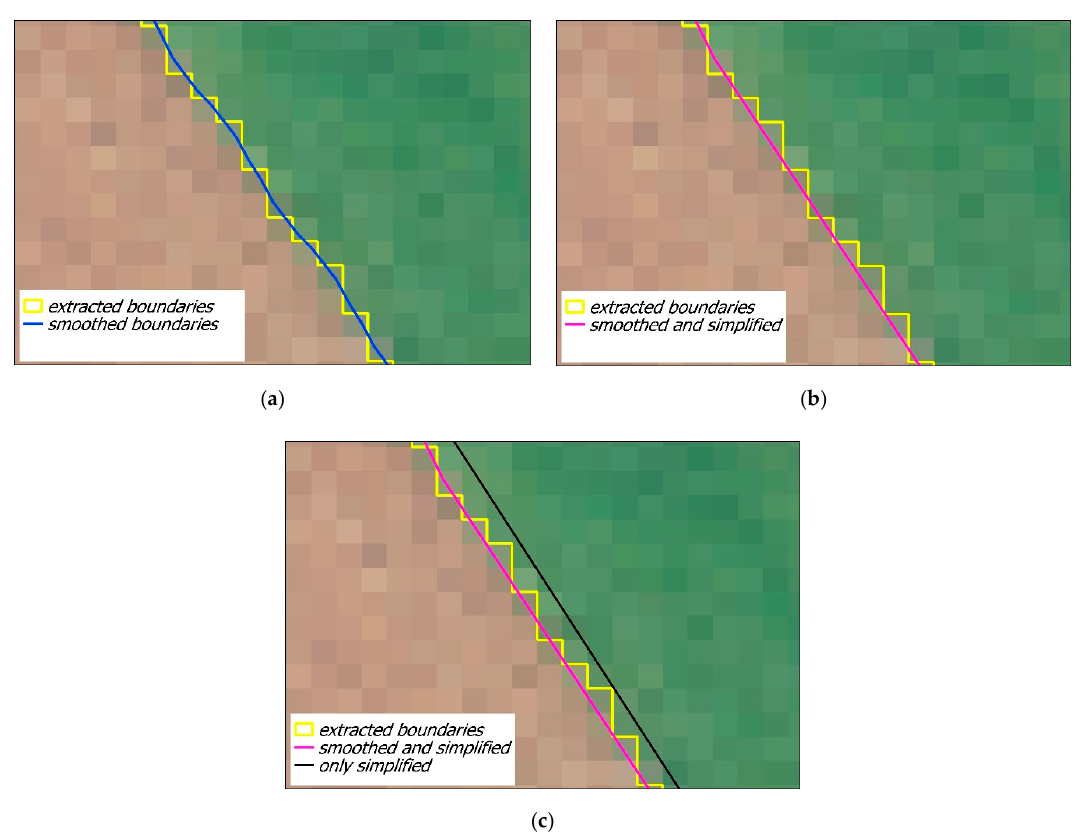
Figure 8. ( a ) Extracted objects smoothed by making use of the Snakes algorithm. ( b ) Simplification of extracted objects by making use of the Snakes smoothing algorithm and Douglas–Peucker simplification algorithm. ( c ) Extracted objects simplified with Douglas–Peucker algorithm (in black) and compared to object simplifications on ( b ).